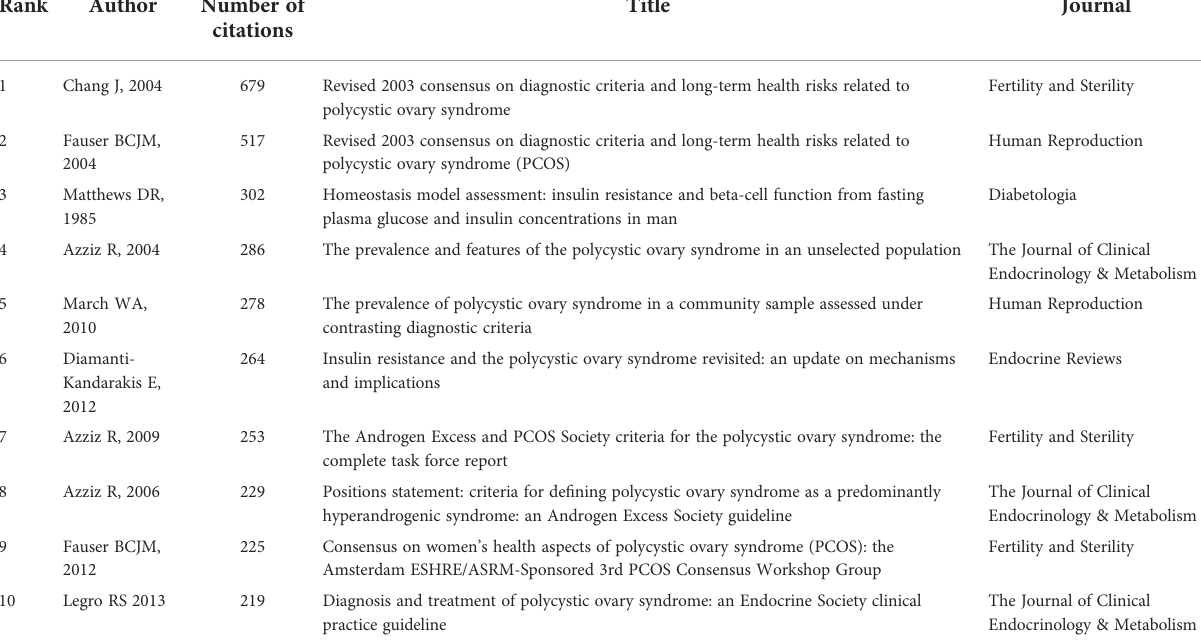
TABLE 4 Analysis of top 10